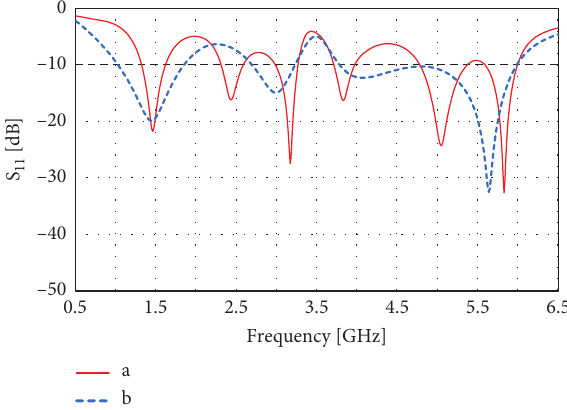
Figure 10: Comparison of microstrip line structure and coplanar waveguide